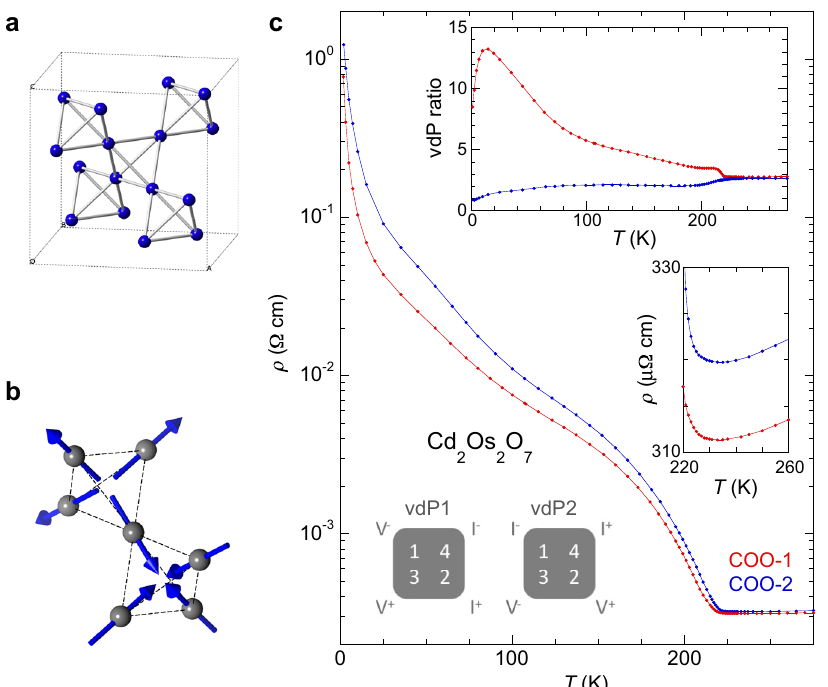
Fig. 1 Transport signatures of Cd 2 Os 2 O 7 at zero fi eld. a Schematic of the Os sublattice in the cubic pyrochlore oxide Cd 2 Os 2 O 7 , with all Os atoms forming a three-dimensional corner-sharing octahedra network. b Schematic of AIAO spin arrangement on two adjacent octahedral. Note that this spin arrangement does not break the underlying lattice symmetry. c Resistivity ρ ( T ) of Cd 2 Os 2 O 7 measured over two single crystals (COO-1 in red and COO-2 in blue) using the vdP con fi guration (Schematics). At each temperature, both vdP channels were measured in order to account for the changing current path between the insulating bulk and conductive domain walls. (Top inset) The resistance ratio R vdP2 / R vdP1 between two vdP channels manifests the changing current path below T N = 227K. (Bottom inset) Details of ρ ( T ) near T N , showing both metallic behavior above T N , and also an upturn of ρ near but still above T N , which is often attributed to dynamical spin fl uctuation effects without long-range order. T N is determined precisely from the magnetic susceptibility χ ( T ), individual R vdP2 ( T ) and R vdP1 ( T ) (not shown), and R H ( T ) in Fig.